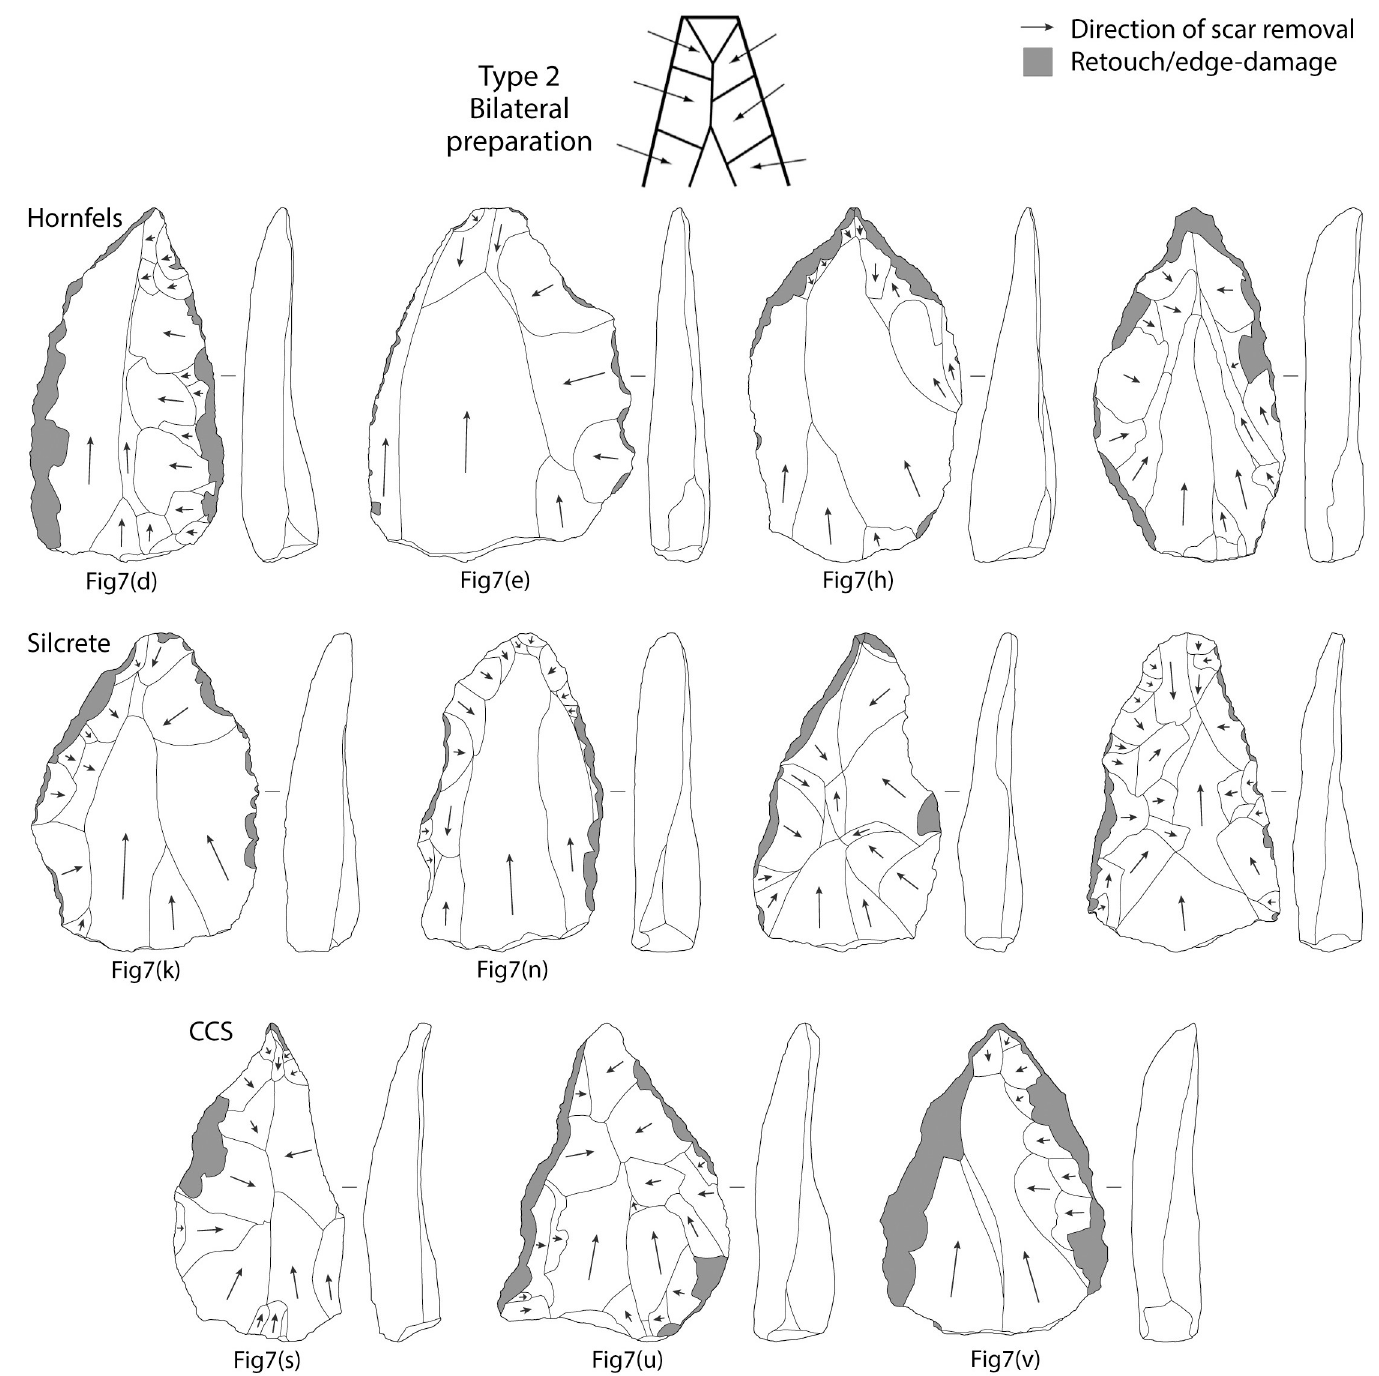
Fig 10. Diagrams of dorsal scar patterning on Tweefontein points related to Nubian Type 2 reduction. Points also illustrated in Fig 7 are indicated. Retouch and edge-damage scars are shaded in grey. Artefacts are not to scale. TWEE7 is a small scatter on the western edge of the high ridge to the north of Tweefontein. There are four Nubian cores, nine retouched and unretouched points, and a high localised incidence of silcrete (n = 20) compared to the low-density scatter across the rest of the ridge